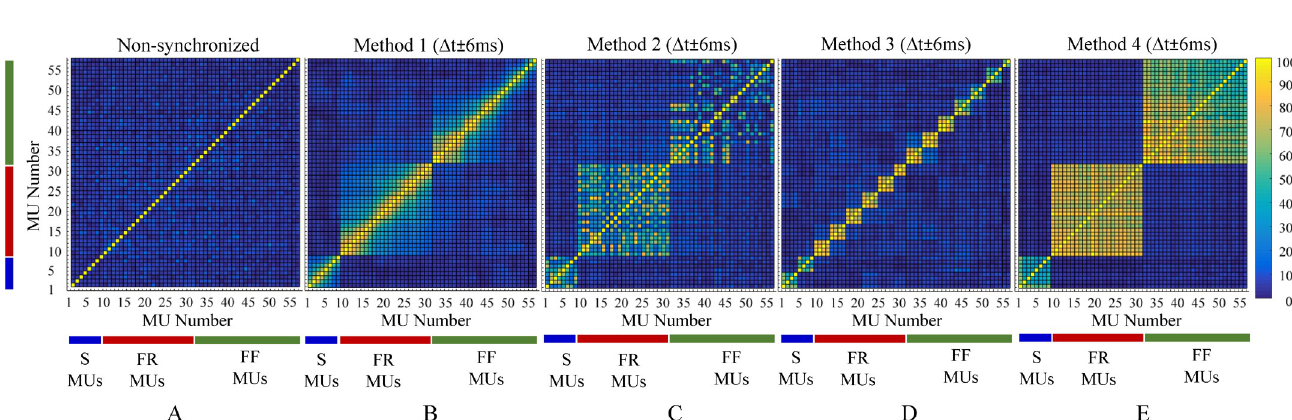
PLOS Computational Biology | https://doi.org/10.1371/journal.pcbi.1008282 April 26,